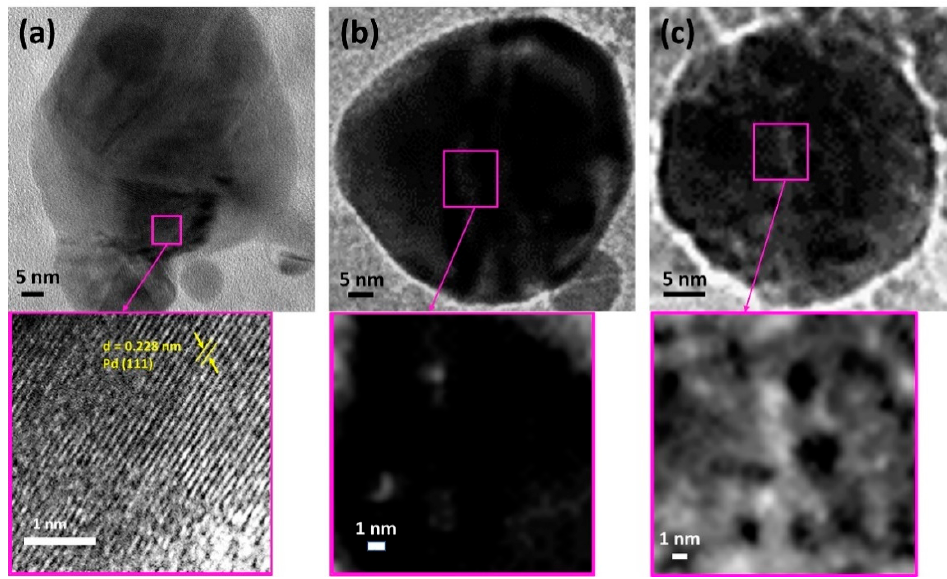
Figure 7. TEM of ( a ) the fresh Pd/SiO 2 catalysts, ( b ) Pd/SiO 2 catalysts annealed at 250 °C in air, and ( c ) after heating/cooling cycle in the CO/O 2 reaction mixture.